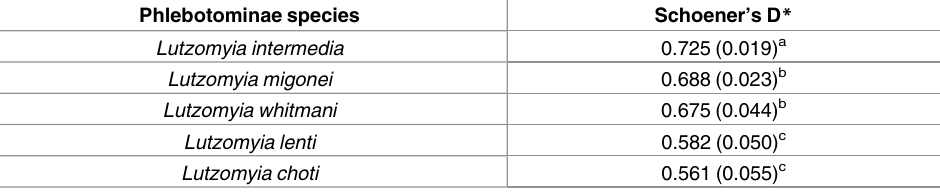
Table 4. Schoener’s D mean and standard deviation for the overlap between 10 replicas of the mod- els of Phlebotominae species and 10 replicas of the cutaneous leishmaniasis model.